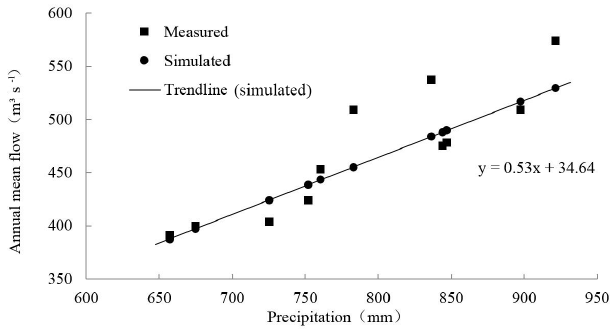
Figure 3. Comparison of simulated and measured annual mean flow from 1985 to 1995.